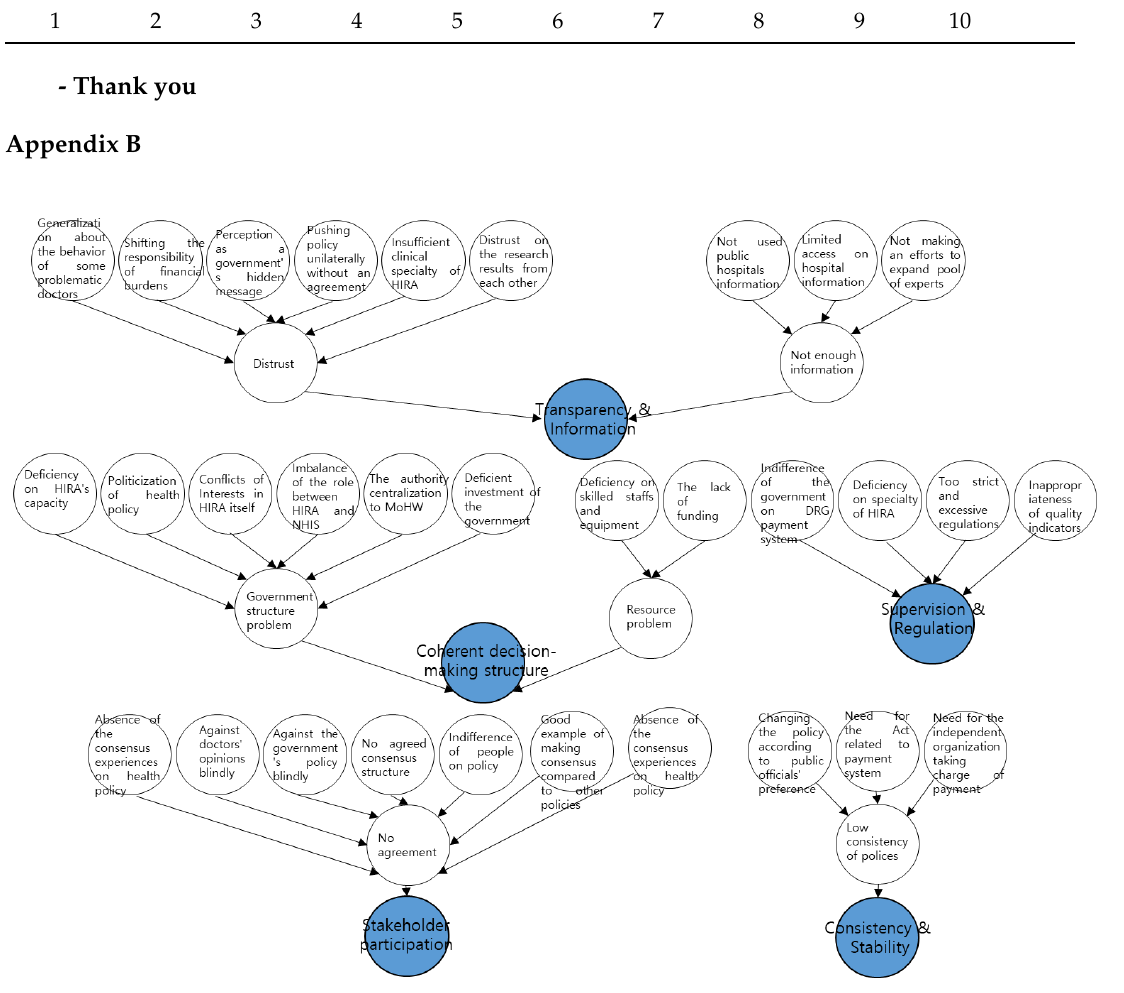
Figure A1. Five major categories and 31 subcategories.